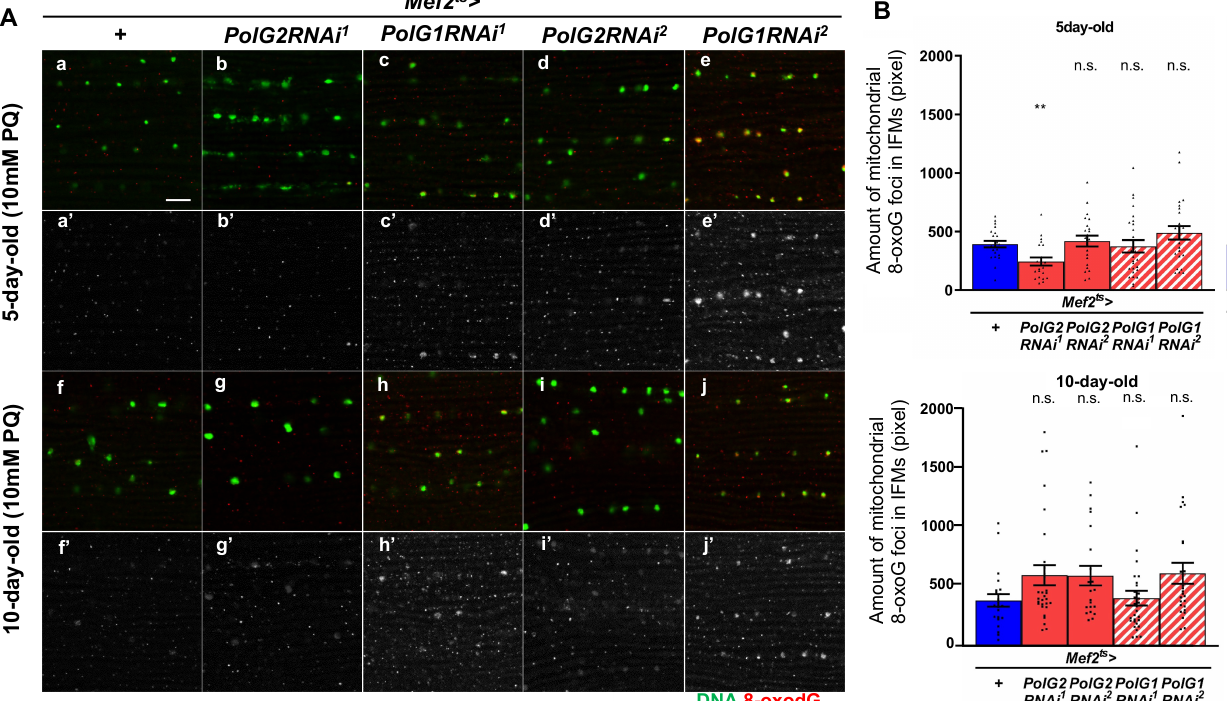
Figure 2. Quantification of mitochondrial DNA (mtDNA) containing 8-oxo-deoxyguanine (8-oxodG) in the indirect flight muscles (IFMs) of the PolG1RNAi or PolG2RNAi adults fed paraquat (PQ). ( A ) Immunostaining of the IFMs collected from 5- and 10-day-old adults fed fly food supplemented with 10 mM PQ revealed with an anti-8-oxodG antibody (red) and PicoGreen for DNA visualiza- tion (green in a – j , white in a’ – j’ ). Scale bar: 10 µ m. PolG2RNAi flies ( Mef2 ts > PolG2RNAi 1 and Mef2 ts > PolG2RNAi 2 ), PolG1RNAi flies ( Mef2 ts > PolG1RNAi 1 and Mef2 ts > PolG1RNAi 2 ), and con- trol flies ( Mef2 ts > + ) were examined. ( B ) Average number of 8-oxodG foci per confocal optical field (4.0 × 10 − 2 mm 2 ) in the muscles of 5- and 10-day-old adults harboring Pol γ RNAi ( Mef2 ts > PolG2RNAi 1 ( n = 21 for 5-day-old, n = 30 for 10-day-old), Mef2 ts > PolG2RNAi 2 ( n = 22, 21), Mef2 ts > PolG1RNAi 2 ( n = 26, 30), and Mef2 ts > PolG1RNAi 1 ( n = 24, 25)) and controls ( Mef2 ts > + ). (** p < 0.01, n.s.; not significant. One-way ANOVA with Bonferroni’s multiple comparisons test). A reduction in the mtDNA copy number is a characteristic feature of mitochondrial dysfunction that becomes apparent with age [41]. We performed qPCR to investigate whether mtDNA copy number in the thoraxes of adults harboring Pol γ RNAi decreased. In control adults ( Mef2 ts > + ), there were no changes in the relative amount of mtDNA to nuclear DNA in the thoraxes between 5- and 36-d-old adults ( n = 3, Student’s t -test) (Figure S1A). However, in 36-d-old adults harboring Pol γ RNAi ( Mef2 ts > PolG2RNAi 1 ), the amount of mtDNA significantly decreased, compared with that in control adults of the same age ( Mef2 ts > + ) ( n = 9) ( p < 0.001, one-way ANOVA with Bonferroni’s multiple comparisons test), but not in other Pol γ RNAi types ( p > 0.05) (Figure S1B). These results suggest that